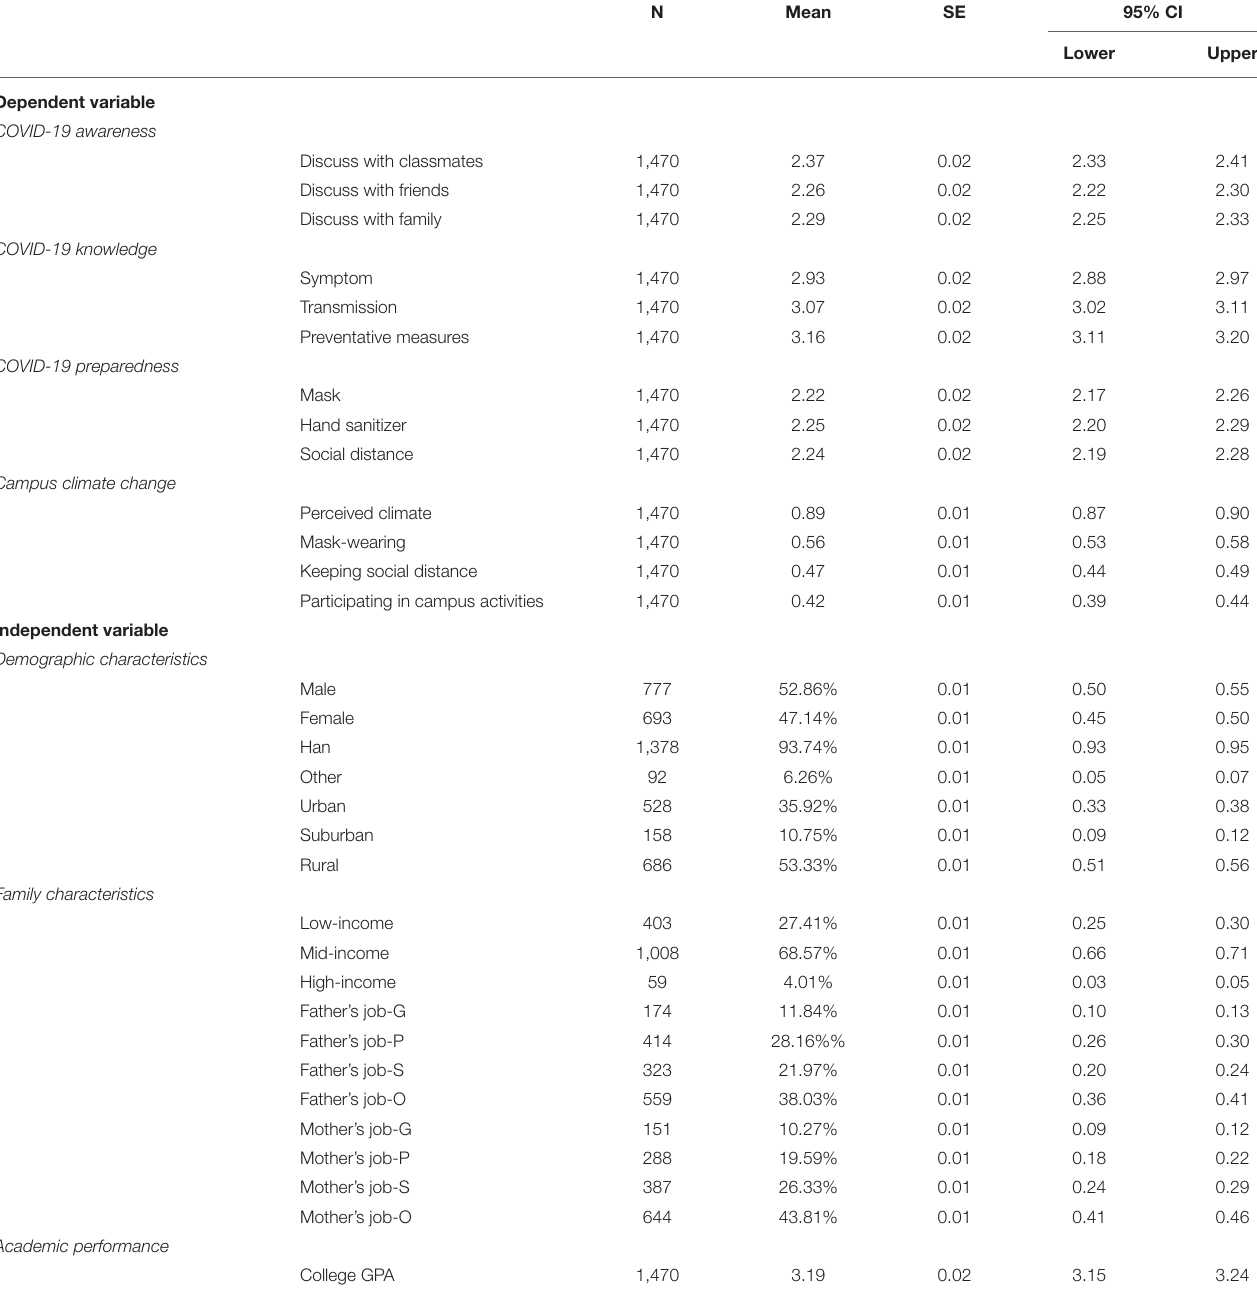
N Mean SE 95% CI